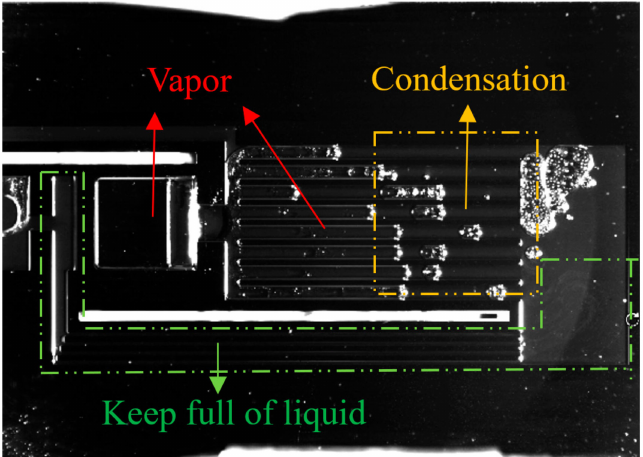
Figure 12. Imaging of the s-UTLHP under high heat